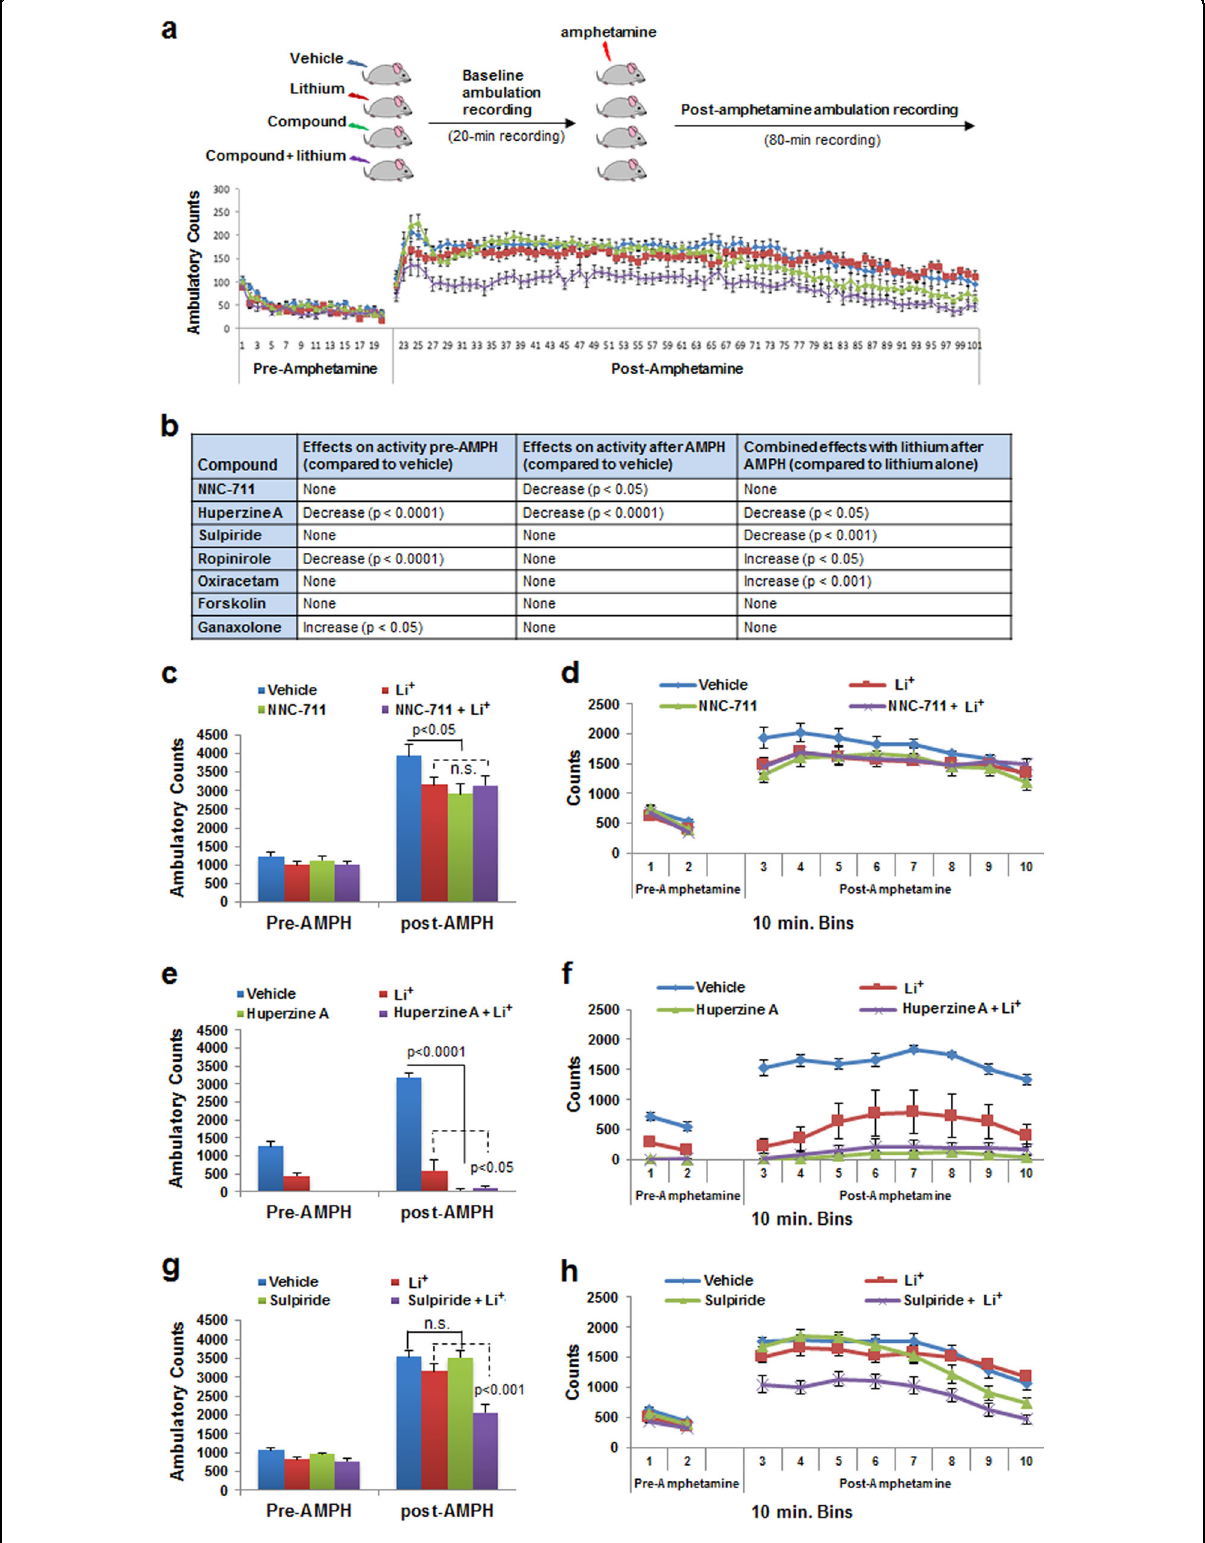
Fig. 5 (See legend on next